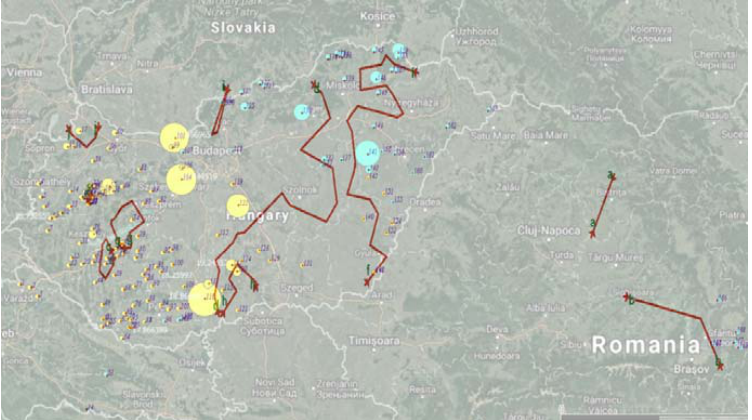
Figure 2. The results of the genetic analysis (Geneland) compared with the geographic analysis (Barrier). Red lines indicates the possible barriers to gene flow